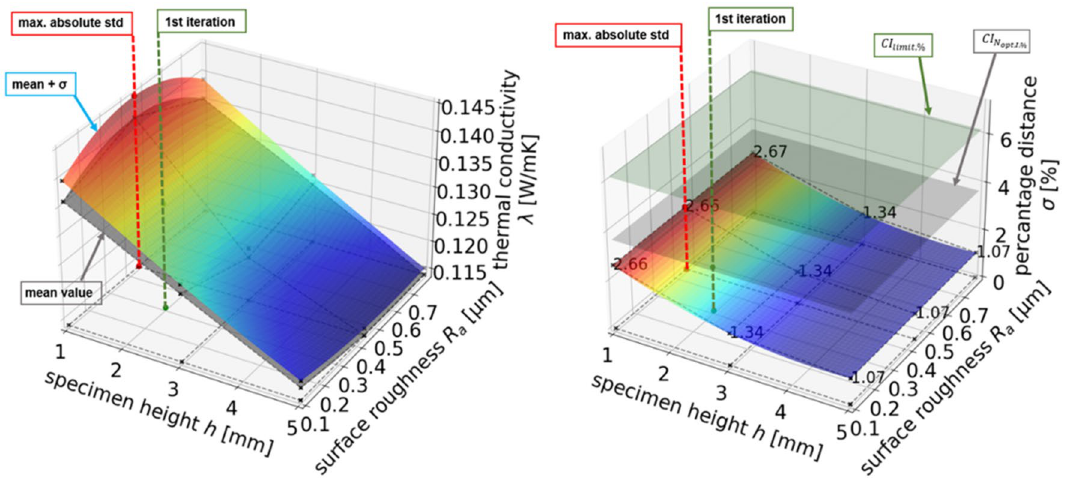
Fig. 2 Error fields green dots—1st iteration; red dots—max. distance of 𝜎 to 𝜇 ; grey dots and dotted lines—measured parameters 𝜇 + 𝜎 (left): grey plane—mean values; coloured plane— 𝜇 + 𝜎 ; 𝜎 % (right): coloured plane— 𝜎 % , grey plane— CI N